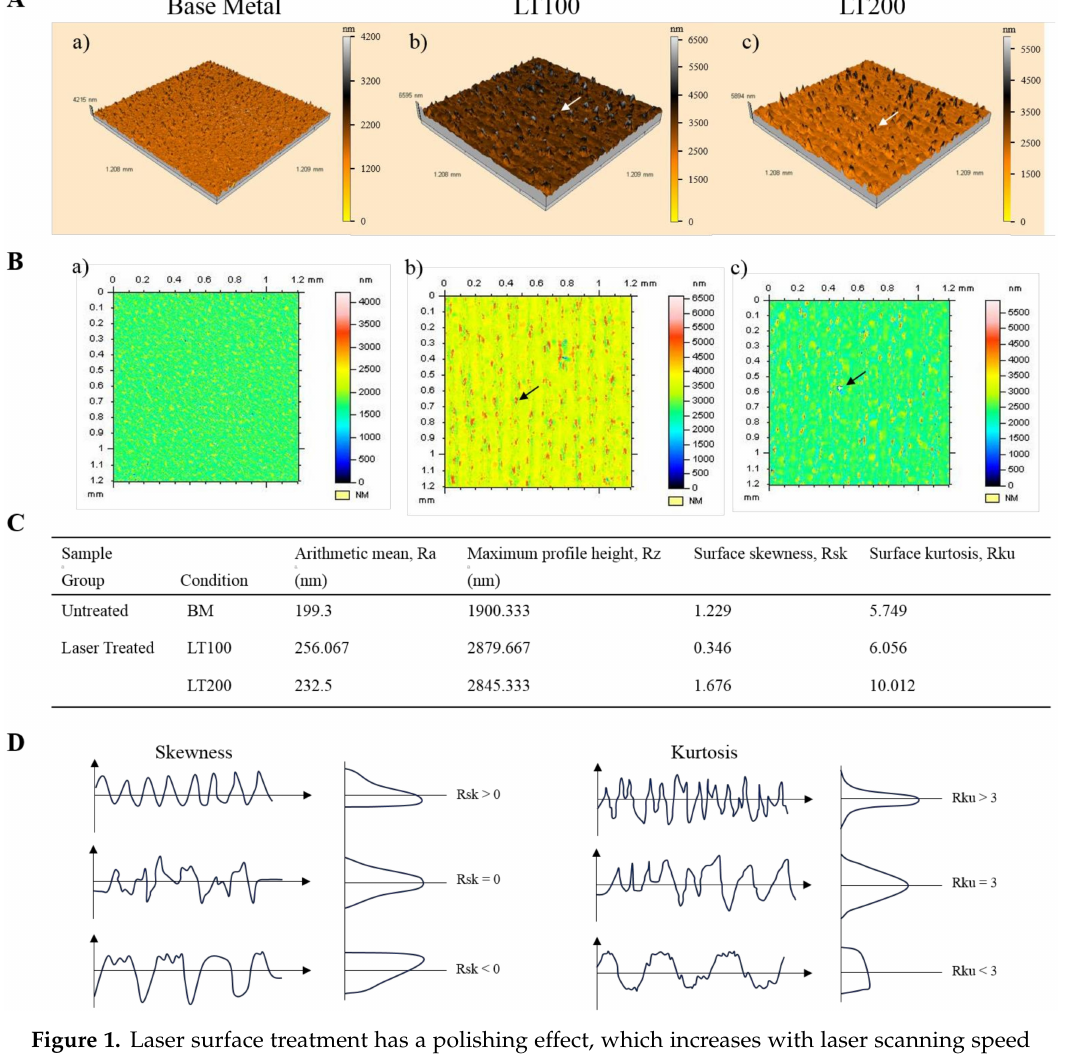
Figure 1. Laser surface treatment has a polishing effect, which increases with laser scanning speed while creating a rough and spiky laser track edge. White light interferometry ( A ) 3D and ( B ) 2D profiles for the untreated and laser treated samples. Scan area of 1.208 mm 2 and 1.2 mm 2 for 3D and 2D images respectively; colour coding of each image seen by individual colour scale in figure. Arrows show the spiky areas at the laser track edges. ( C ) Summary of surface roughness parameters. ( D ) Diagrams illustrating visual difference between surface skewness and kurtosis